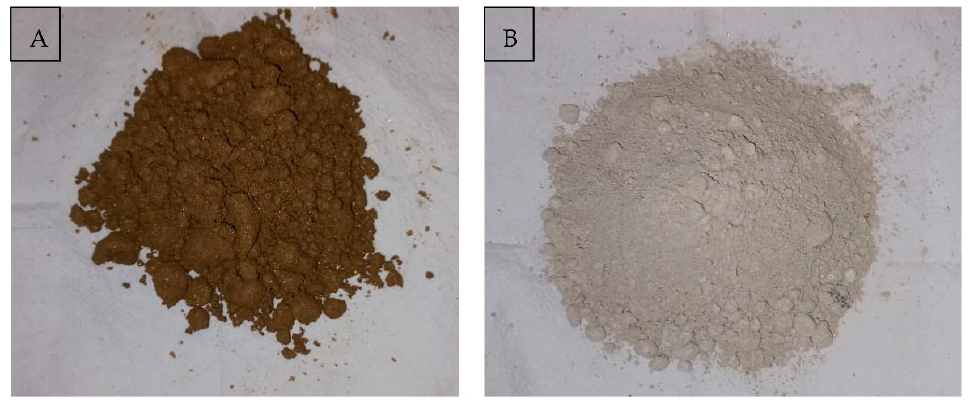
Figure 1. Raw materials used to manufacture the ceramic artifact: ( A ) ceramic mass, ( B ) ornamental stone waste.